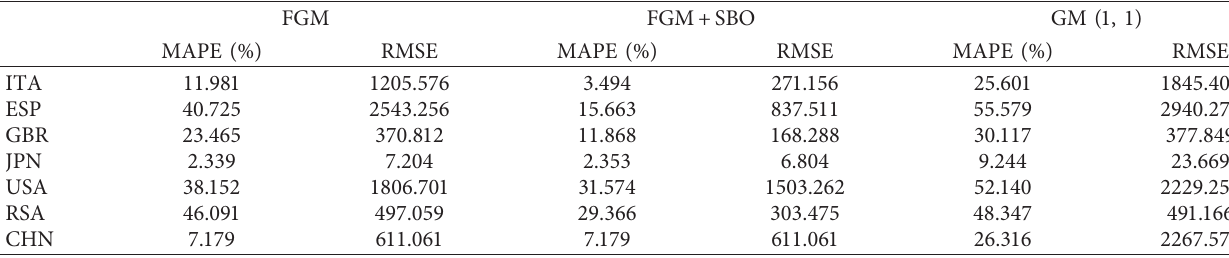
Table 2: The prediction performance.